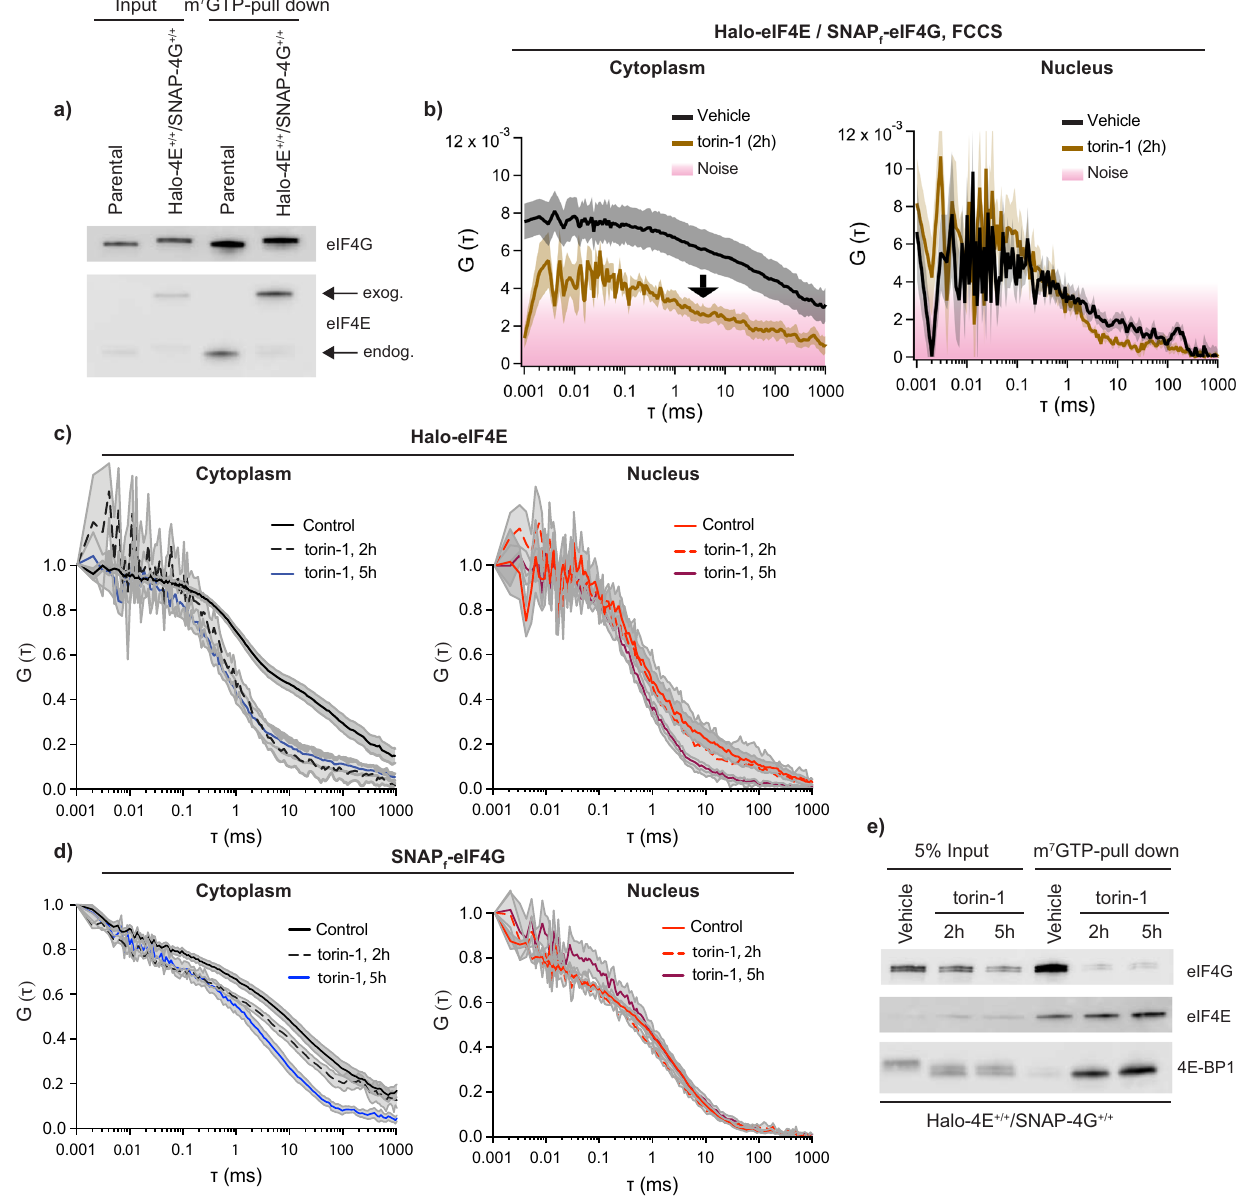
Fig. 3 | eIF4E and eIF4G binding to the mRNA is detected by FCS upon mTOR inhibition. a Parental mESC and double knock-in Halo-eIF4E +/+ /SNAP-eIF4G +/+ total cell lysates (input) were subjected to cap-pull-down assay (m 7 GTP-pull- down) and analyzed by western blotting. eIF4G and eIF4E antibodies showed binding of wild-type and tagged proteins to the 5 ’ cap. Tagging of endogenous eIF4E and eIF4G did not affect cap-binding as compared to the parental counterpart. b – e Halo-eF4E +/+ /SNAP-eIF4G +/+ cells were treated with vehicle (DMSO) or 250 nM torin-1 for 2 h and 5 h respectively. b Simultaneous diffu- sion of JF585 Halo-eIF4E and JF646 SNAP f -eIF4G was analyzed by dual color cross- correlation spectroscopy (FCCS) in the indicated conditions. Cross- correlation was detected in the cytoplasm of control cells ( left panel ), but not in the nucleus ( right panel ). Minor residual eIF4E:eIF4G was detected in the